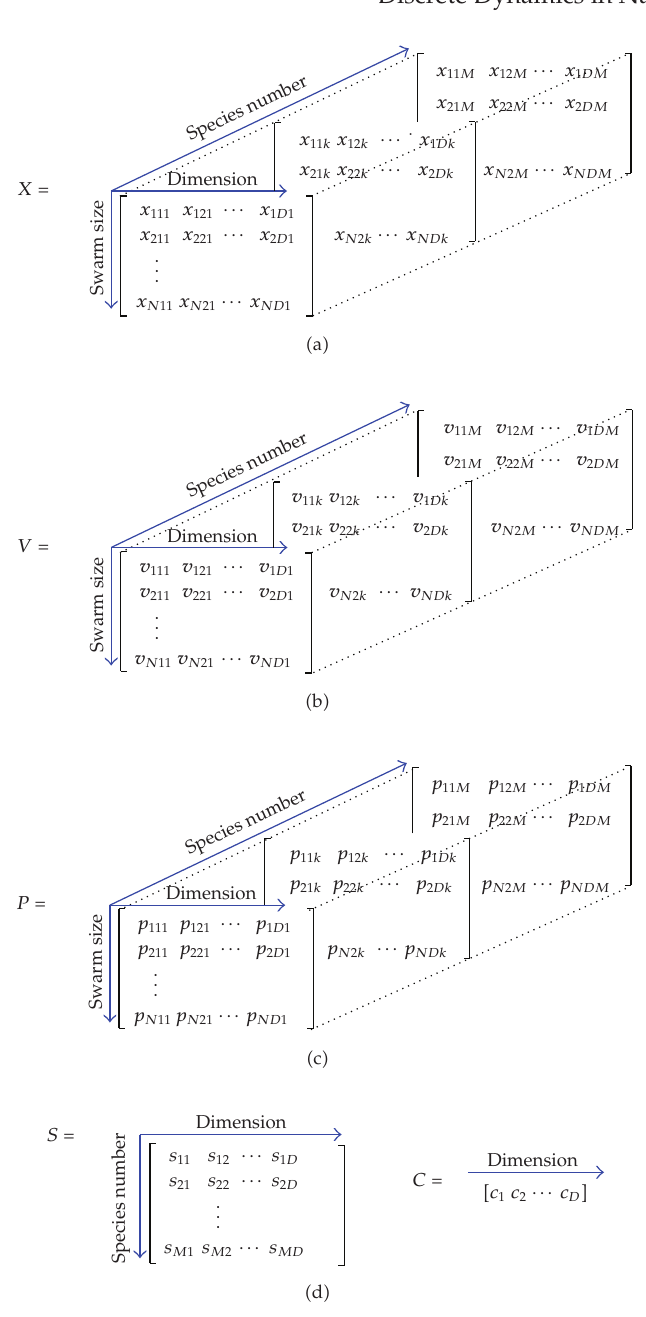
Figure 6: Matrix representation of the PS 2 O